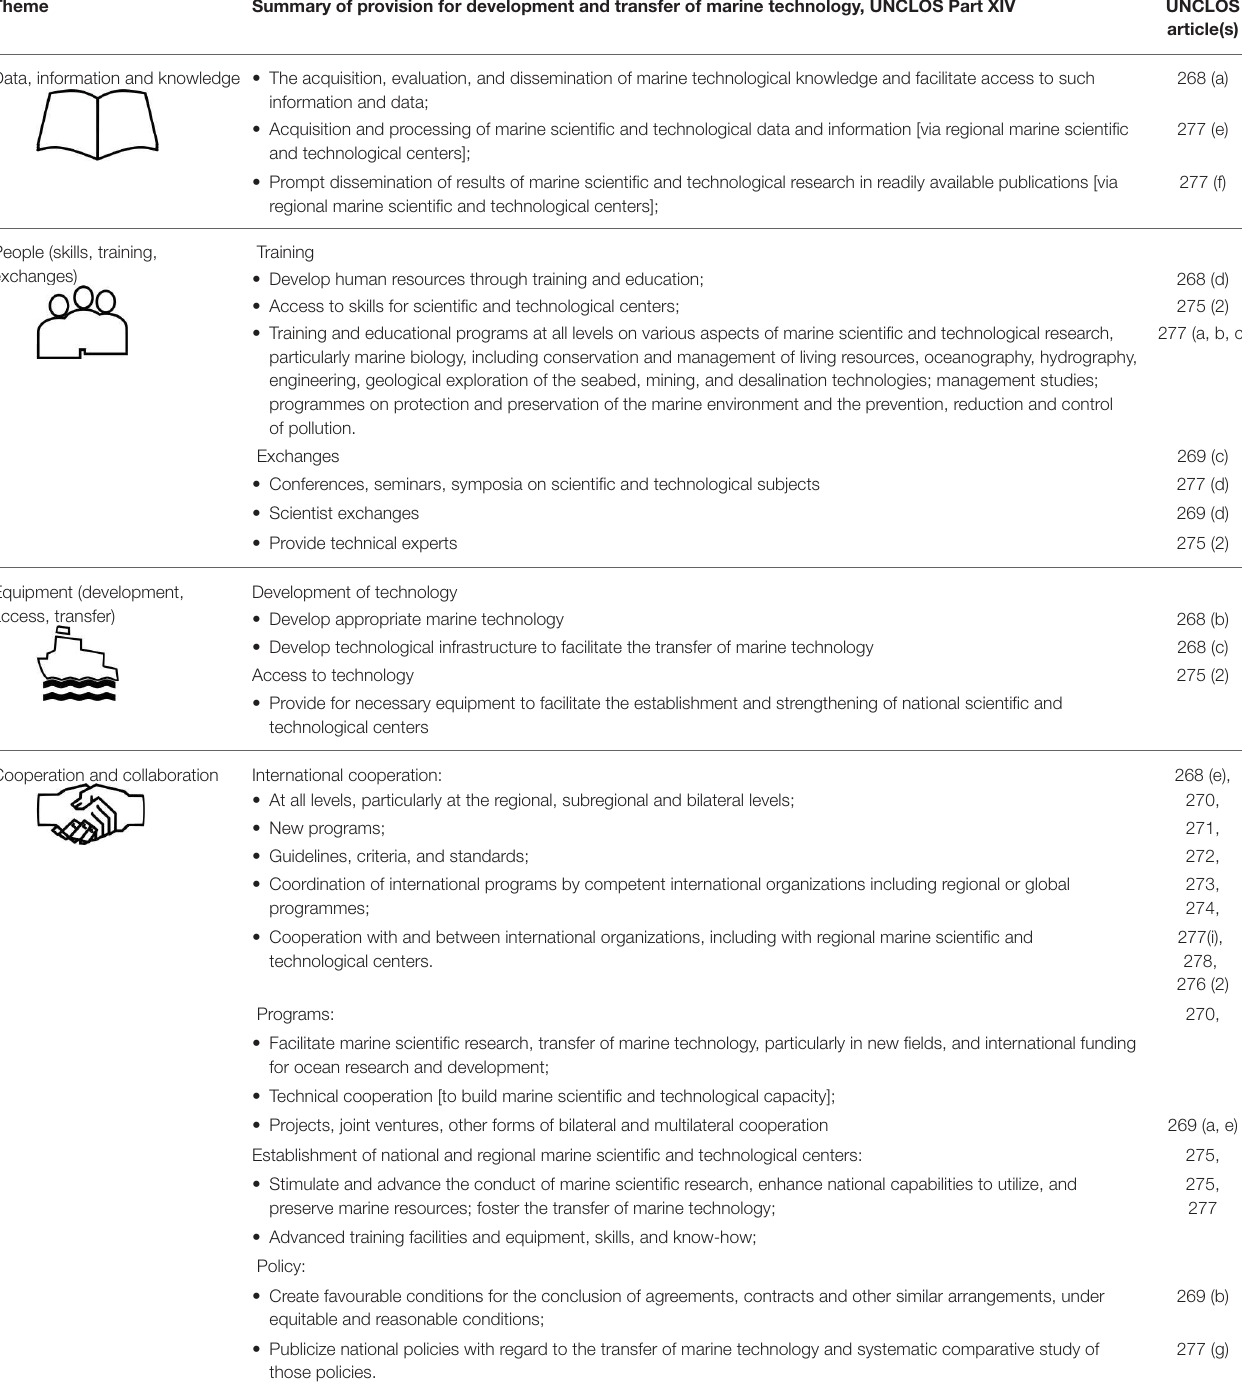
TABLE 1 | UNCLOS Part XIV